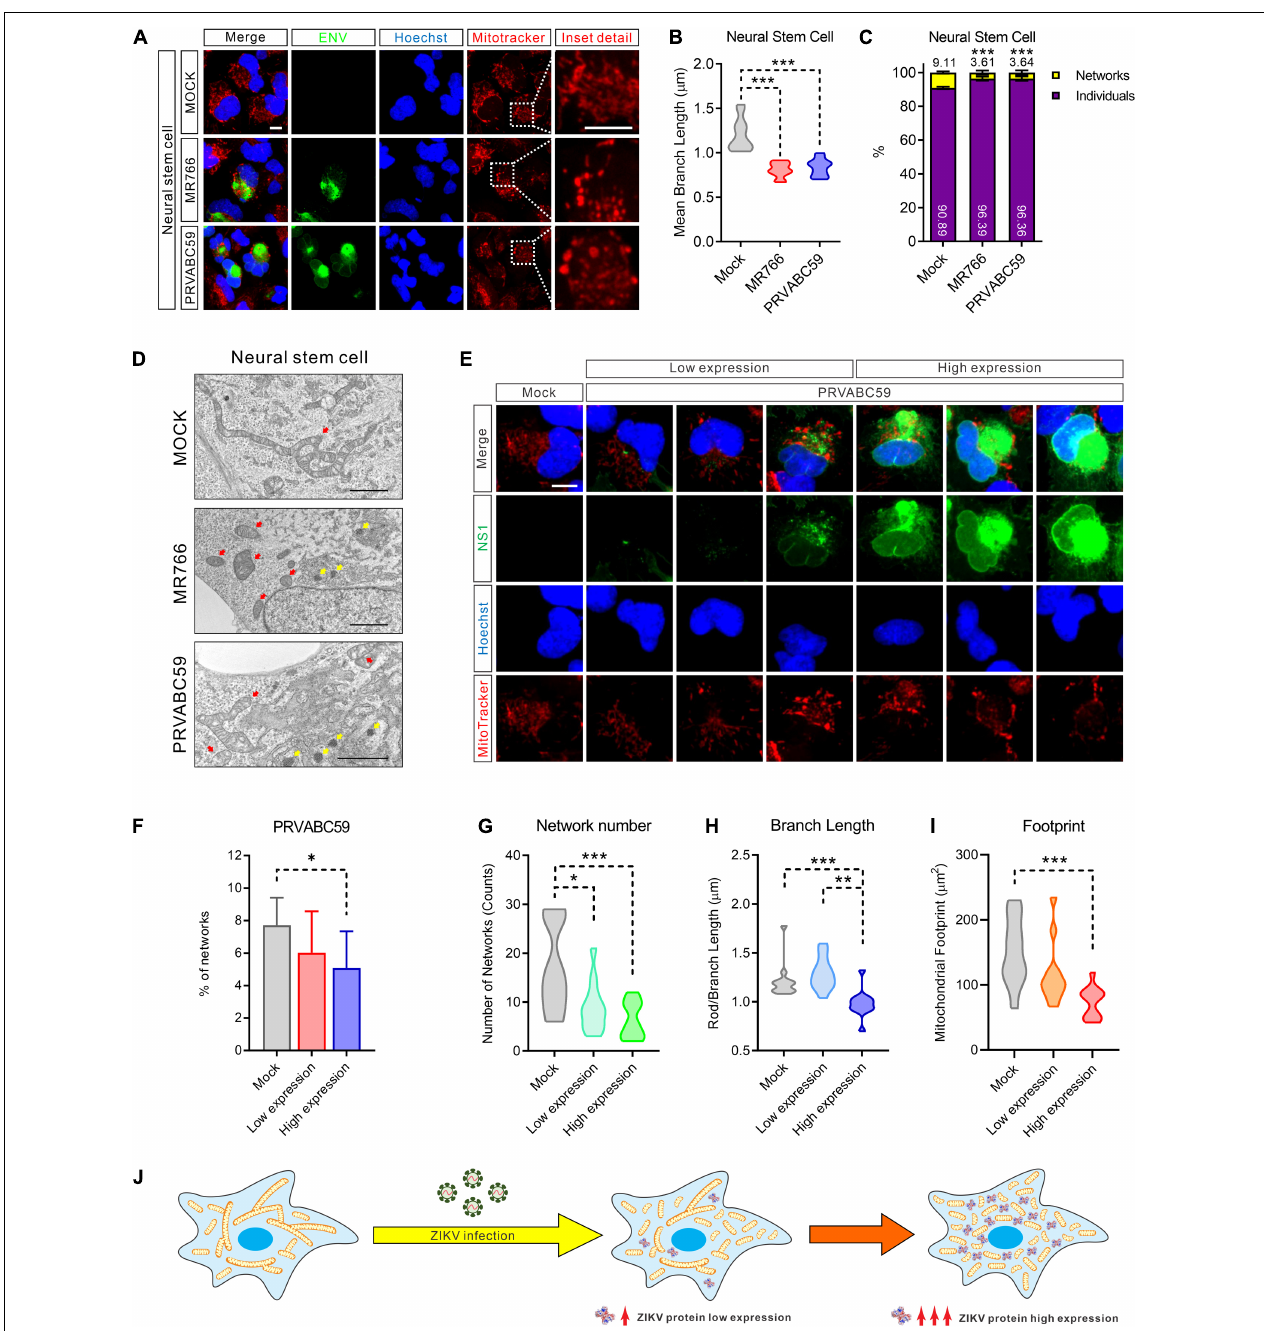
FIGURE 2 | ZIKV induced mitochondria fragmentation. (A) Fluorescence images of NSCs 24 h after infection with MR766, PRVABC59, or mock control and stained for ZIKV ENV (green), nuclei (Hoechst, blue), and mitochondria (MitoTracker, red). Scale bar, 10 µ m. (B) Violin plot of the mean mitochondrial branch length in (A) ( n = 12). (C) The average percentage of the mitochondrial network and individual structures in (A) ( n = 12). (D) Electron microscope imaging data of Mock, MR766, or PRVABC59-infected NSCs. Scale bar, 2 µ m. Red arrows indicate mitochondria; yellow arrows indicate the virus particles in the rough endoplasmic reticulum. (E) Fluorescence images of SNB-19 infected with ZIKV PRVABC59 for 24 h and stained for ZIKV NS1 (green), nuclei (Hoechst, blue), and mitochondria (MitoTracker, red). Scale bar, 5 µ m. (F) The average percentage of mitochondrial networks and individual structures in (E) ( n = 12). (G–I) Violin plot representing the numbers of mitochondrial networks (G) , mean branch length (H) , and footprint (I) in (E) ( n = 12). (J) A diagram shows the mitochondrial fragmentation in ZIKV-infected cells, and the fragmentation severity is positively related to the ZIKV protein expression level. All P -values were calculated by one-way ANOVA with Tukey’s multiple-comparison. ∗ p < 0.05, ∗∗ p < 0.01, and ∗∗∗ p < 0.001.